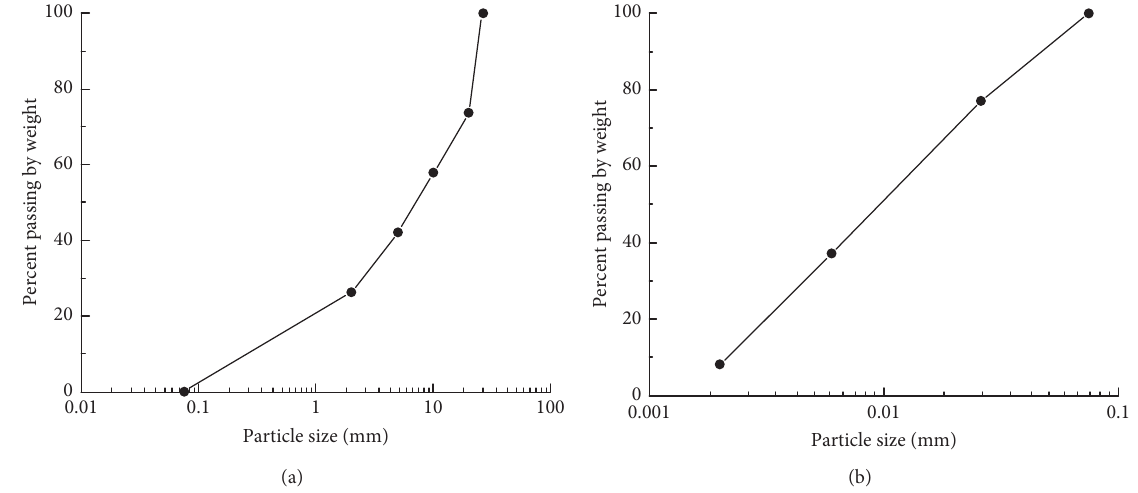
Figure 1: Grain size distribution for (a) coarse-grained portion and (b) fine-grained portion.